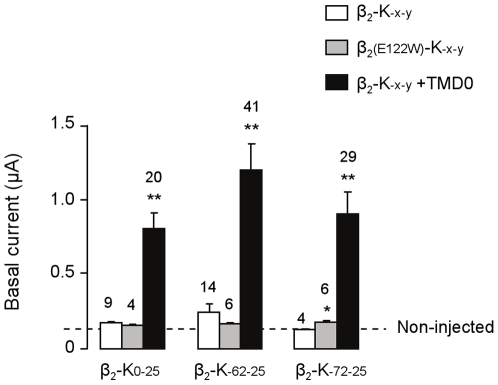
TMD0 of SUR boosts expression of β2-based ICCRs.Basal currents are the whole-cell currents measured in the first minute of TEVC recording from unstimulated Xenopus oocytes. E122 W is a mutation of residue 122 of β2AR from Glu to Trp reported to increase β2 surface expression.TMD0 is the first transmembrane domain of the sulfonylurea receptor SUR1, a physiological partner of Kir6.2. *P<0.05 and **P<0.00001 represent significant differences from the basal current measured in non-injected oocytes.